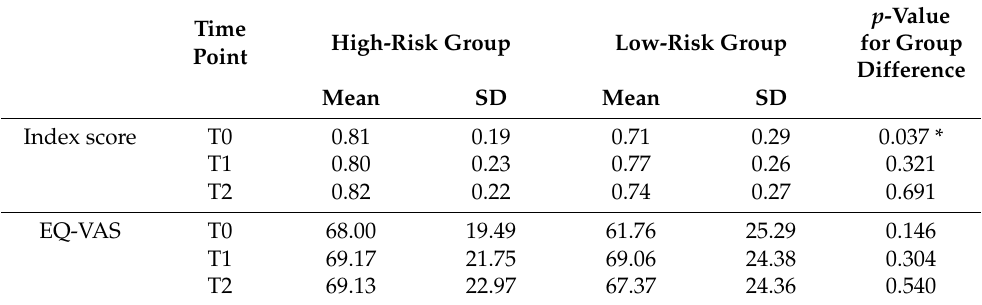
Table 4. Comparison of the high-risk group and the low-risk group over the time points T0, T1, and